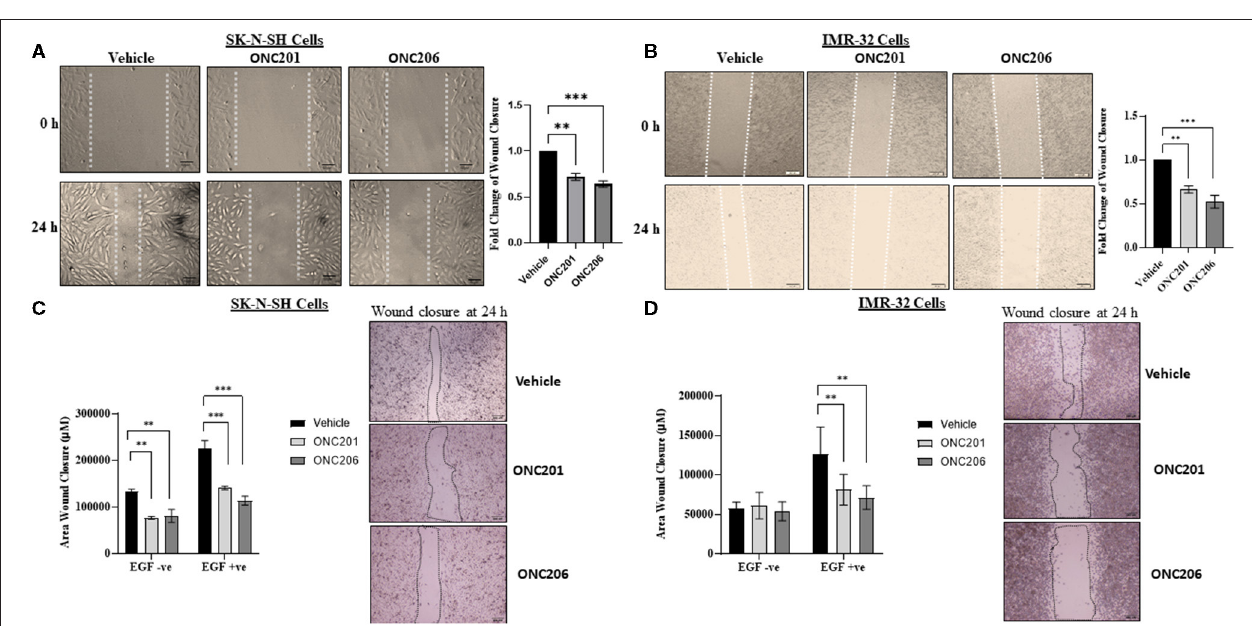
FIGURE 3 | Cellular migration inhibited with ONC201/ONC206 treatment. SK-N-SH (A) and IMR-32 (B) cells treated with either ONC201 (5 µ M) or ONC206 (0.5 µ M) exhibited a significant reduction in cellular migration compared with vehicle-treated cells. SK-N-SH (C) and IMR-32 (D) cells treated with either ONC201 (5 µ M) or ONC206 (0.5 µ M) exhibited a significant reduction in EGF-induced cellular migration as assessed using the wound-healing assay. Experiments were conducted in triplicates and repeated three times. Data represent the mean ± the standard error of the mean (SEM) of multiple experiments. ** p < 0.01; *** p < 0.001.